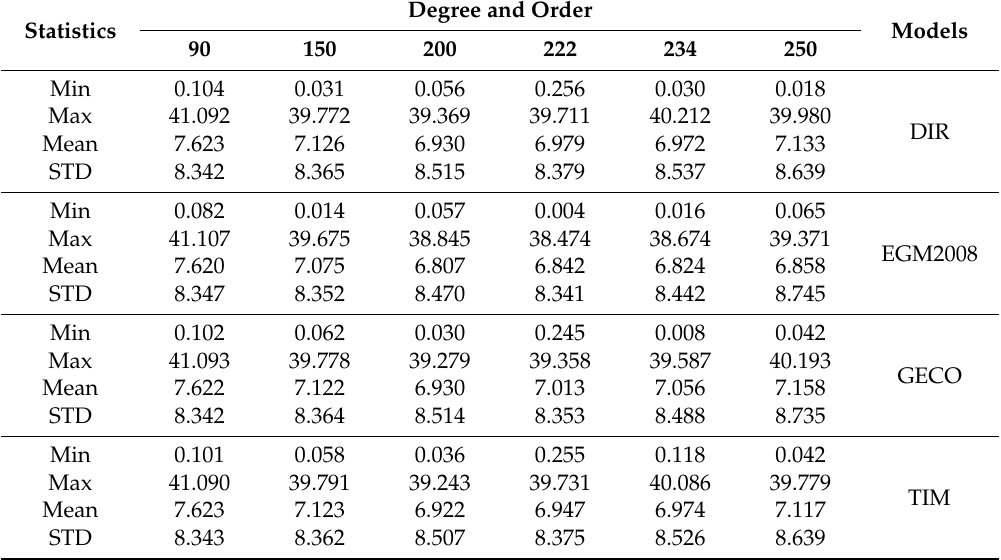
Table 3. Statistics of relative validation of gravimetric geoid models using Equation (19). All values are in